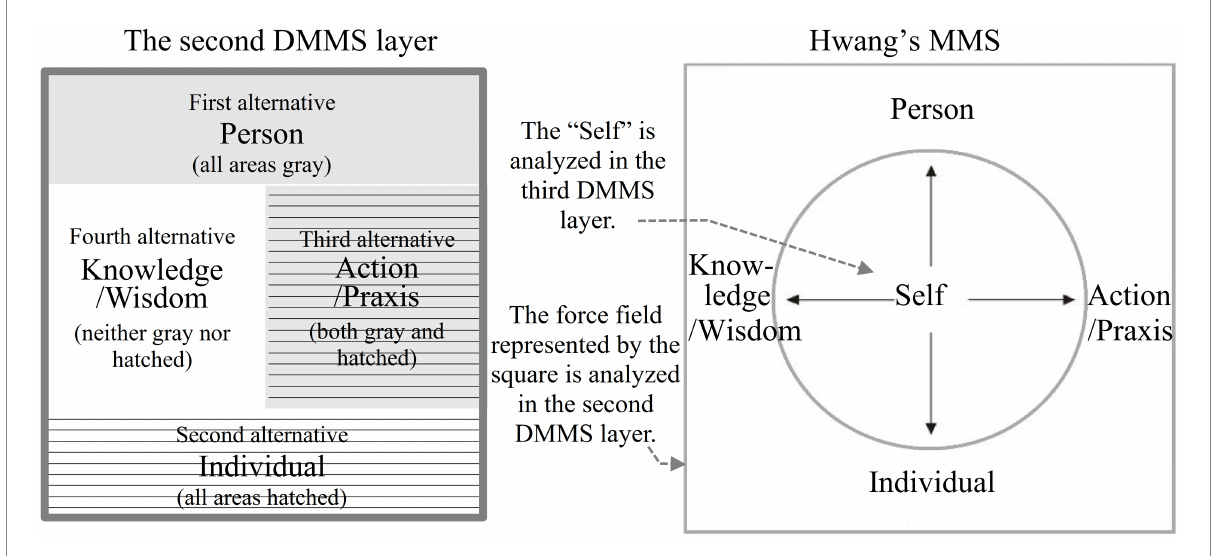
FIGURE 8 The second Dialectical Mandala Model of Self-cultivation (DMMS) layer and Hwang’s (2011) Mandala Model of Self